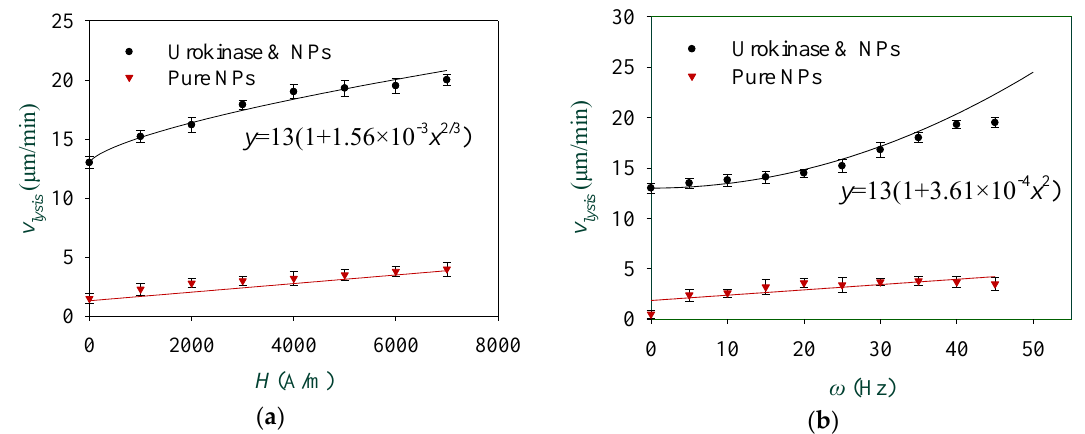
Figure 9. ( a ) Thrombolysis speed reveals a nonlinear dependence to the strength of the RMF; ( b ) Thrombolysis speed shows a quadratic dependence to the driving frequency of the RMF.